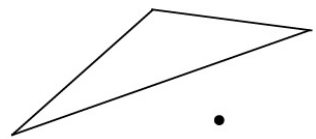
Figure 20: Deletion of a point.